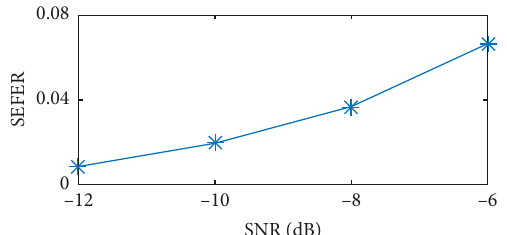
Figure 3: The TFR variation tendency with different